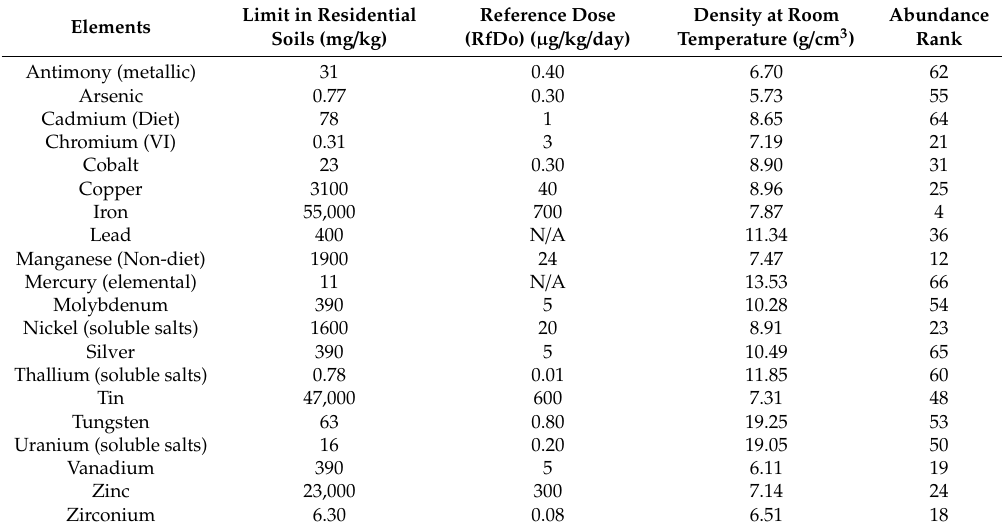
Table 1. Elements classified as heavy metals according to a density at room temperature of more than 5 g / cm 3 . The values for the limit in residential soils and oral reference dose were obtained from the U.S. Environmental Protection Agency (USEPA) for June 2020 [11]. The density at room temperature values was obtained from Shackelford et al. [12]. The abundance rank of the elements in the Earth’s crust was extrapolated from Anderson